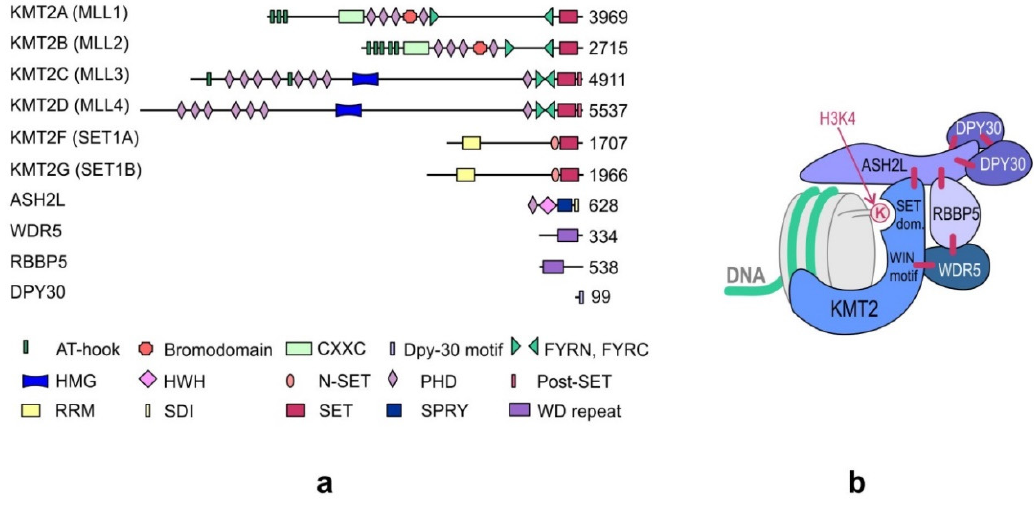
Figure 1. ( a ) Domain structure of the KMT2 family and core subunits of the KMT2 complexes. The numbers indicate the number of amino acids. KMT, histone–lysine N-methyltransferase; ASH2L, absent, small, or homeotic 2-like; DPY30, Dumpy-30; RBBP5, retinoblastoma-binding protein 5; WDR5, WD repeat-containing protein 5; AT-hook, adenosine-thymidine-hook; CXXC, Zinc finger-CXXC domain; FYRN/FYRC, phenylalanine and tyrosine-rich region (N- and C-terminal); HMG, high mobility group; HWH, helix-wing-helix domain; N-SET, N-terminal of SET; PHD, plant homeodomain; Post-SET, C-terminal of SET; RRM, RNA recognition motif ; SDI, Sdc1-Dpy-30 tryptophan-aspartic acid repeat. ( b ) The structure of the KMT2 complex. The enzyme and the